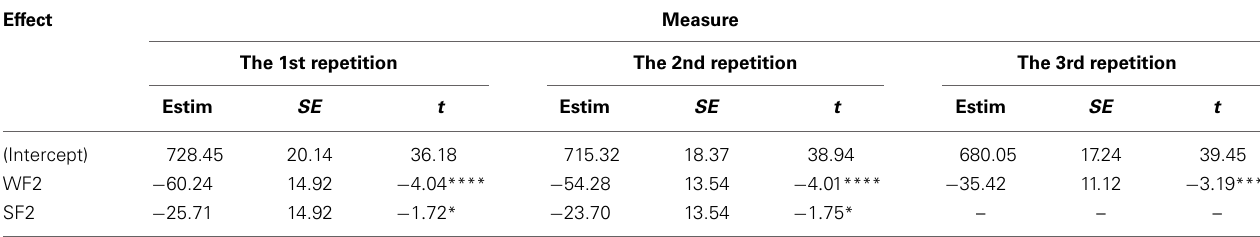
Table 3 | LMM estimates of fixed effects for latencies for each repetition in